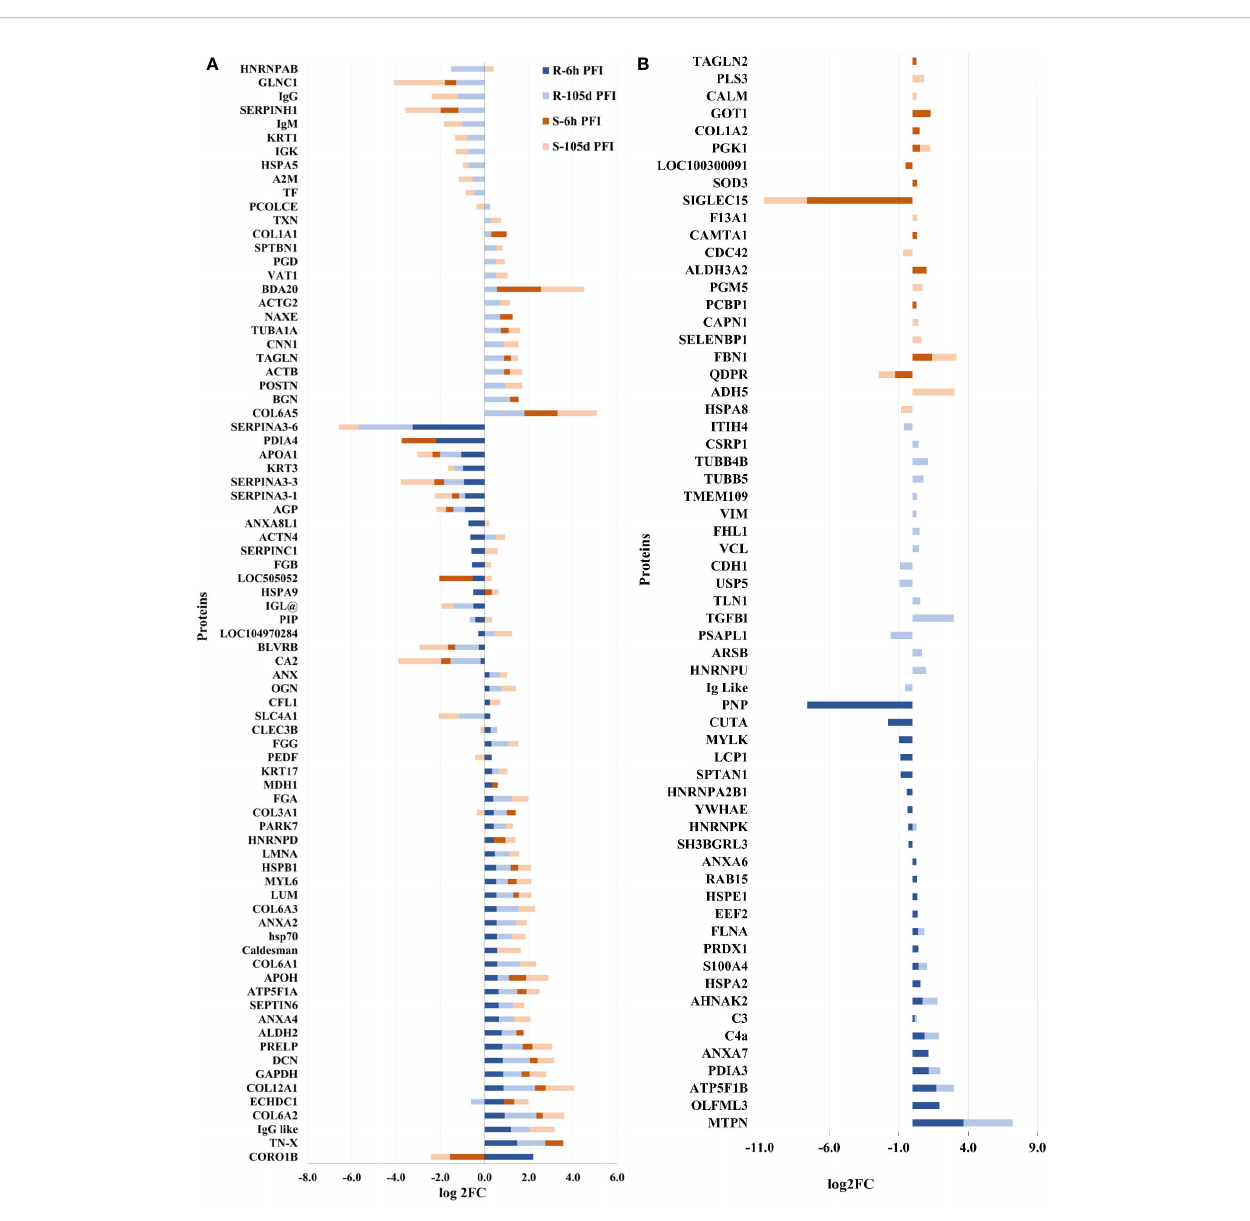
Supplementary File 1: Table S8.3). In resistant cattle, similar to